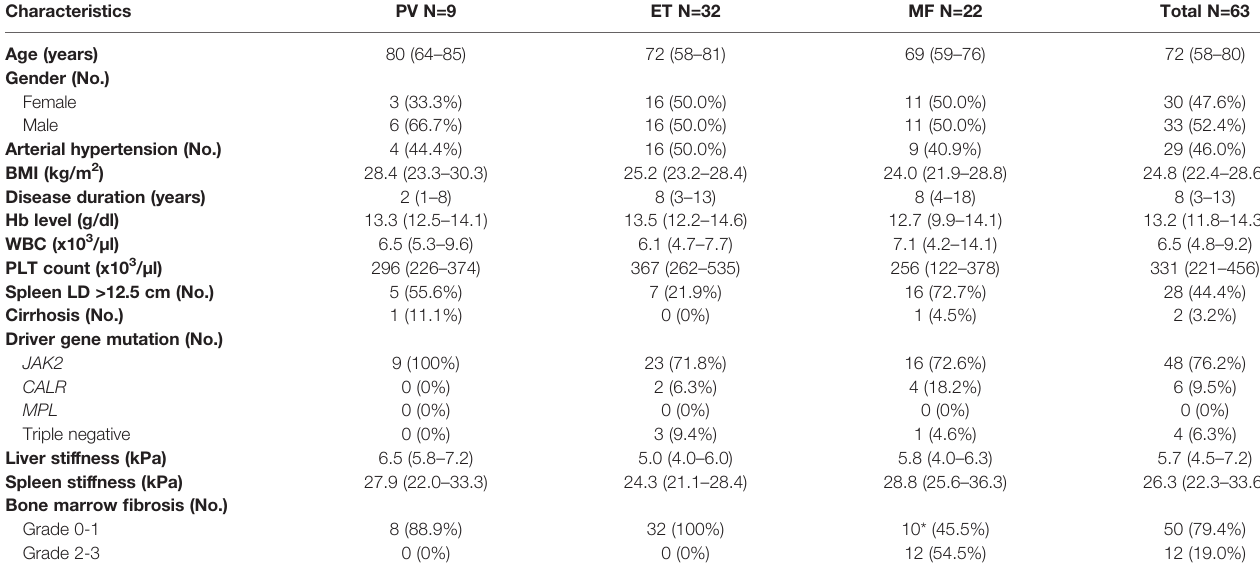
TABLE 1 | Patients characteristics.